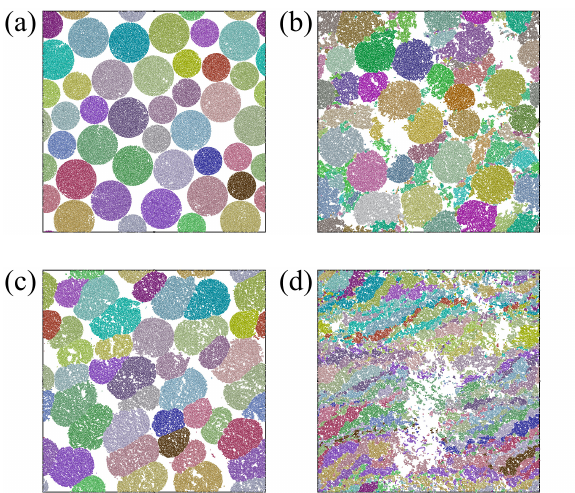
Figure 2. Typical snapshots of the system: (a) initial configura- tion and (b) configuration after applying the shear strain γ = 1 . 0 for ˙ γ ∗ = 1 . 0 × 10 − 4 . Panels (c) and (d) are those after applying the shear strain γ = 1 . 0 and 10 . 0, respectively, for ˙ γ ∗ = 1 . 0 × 10 − 3 . The color represents the initial belonging of the particles to the